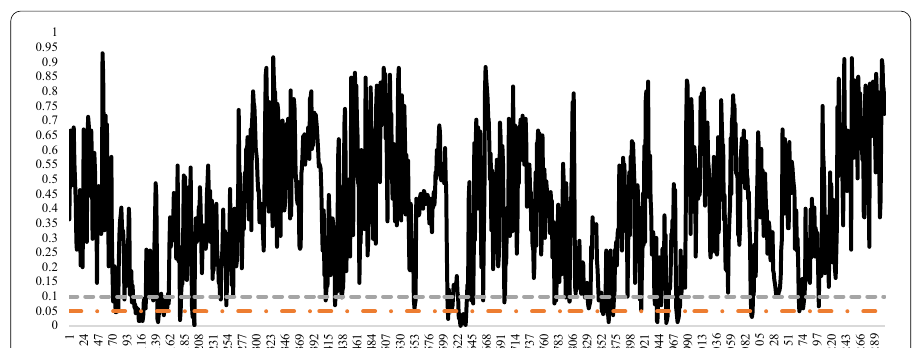
Fig. 26 The evolving p values of the GS test statistic checked for the Ripple (XRP) in 50-day window length